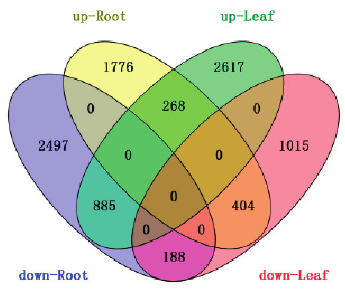
Figure 2. Overlap of differentially expressed genes in root and leaf in response to drought. Four-way Venn diagram showed the overlap of up- and down-regulated differentially expressed genes in root and leaf in response to drought stress. Regions corresponding to genes that are up-regulated commonly in both root and leaf are shaded in green. Regions corresponding to genes that are down-regulated commonly in both root and leaf are shaded in purple. Regions corresponding to genes that are up-regulated in leaf and down-regulated in root are shaded in blue. Regions corresponding to genes that are up-regulated in root and down-regulated in leaf are shaded in